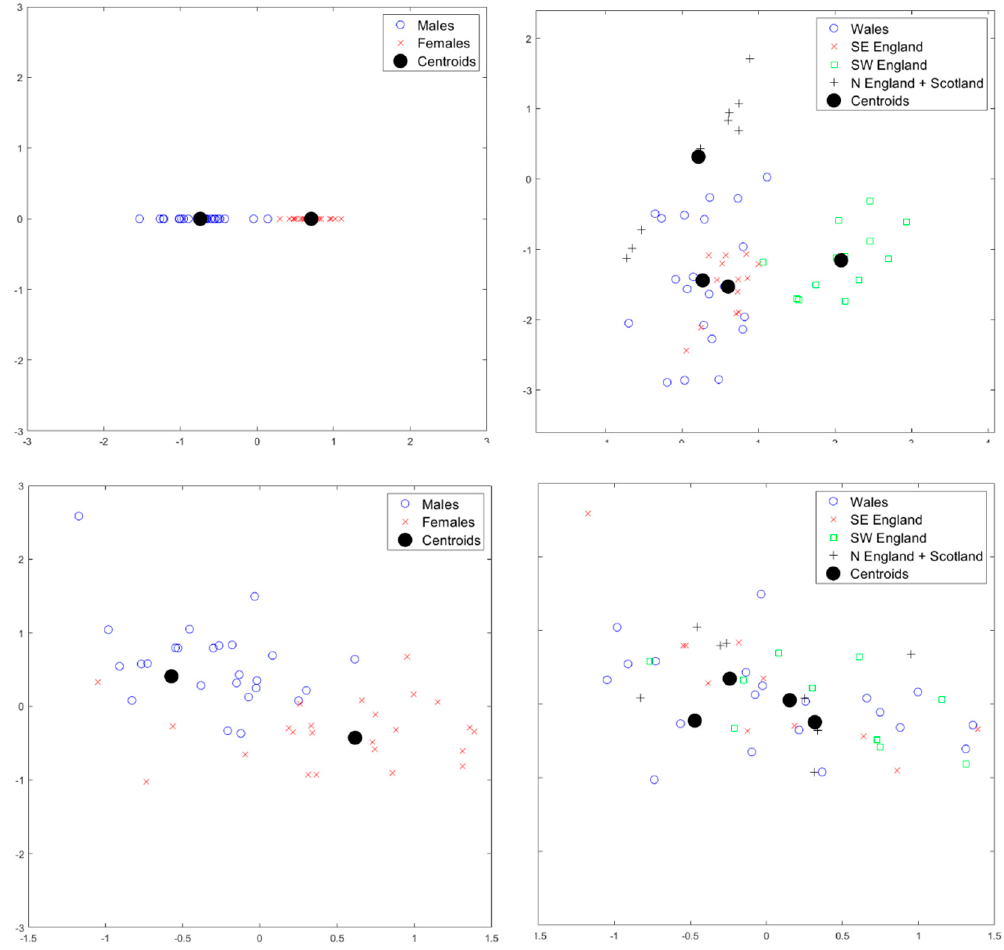
Figure 8. Results of mPCA for standardized component scores ( x -axis: component 1; y -axis: component 2) for the unscaled shape data. Results of mPCA with m 1 = 1; m 2 = 3; m 3 = 20 in Equation (A4) are shown in the top row: ( left ) level 1, which shows a strong clustering by sex; ( right ) level 2, which shows clustering by geographical area. Results of single-level PCA are shown in the bottom row: ( left ) symbols chosen by sex; ( right ) symbols chosen by geographical area.